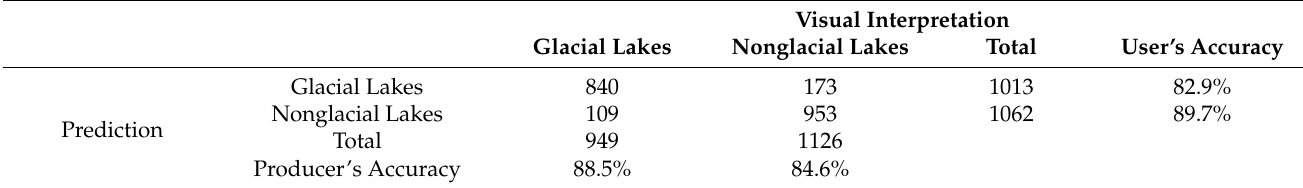
Table 6. Confusion matrix of the alpine lake